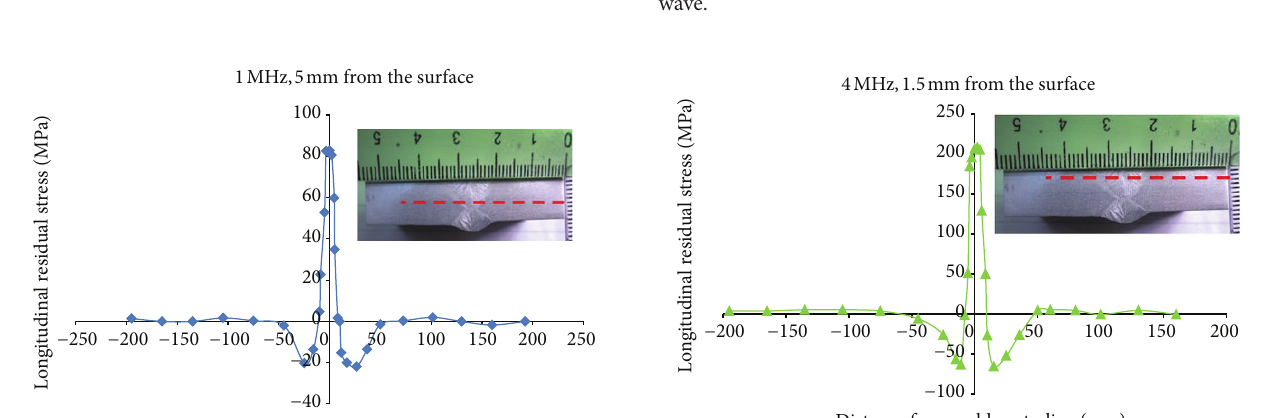
Figure 9: Ultrasonic stress measurement results by 2MHz L CR wave.